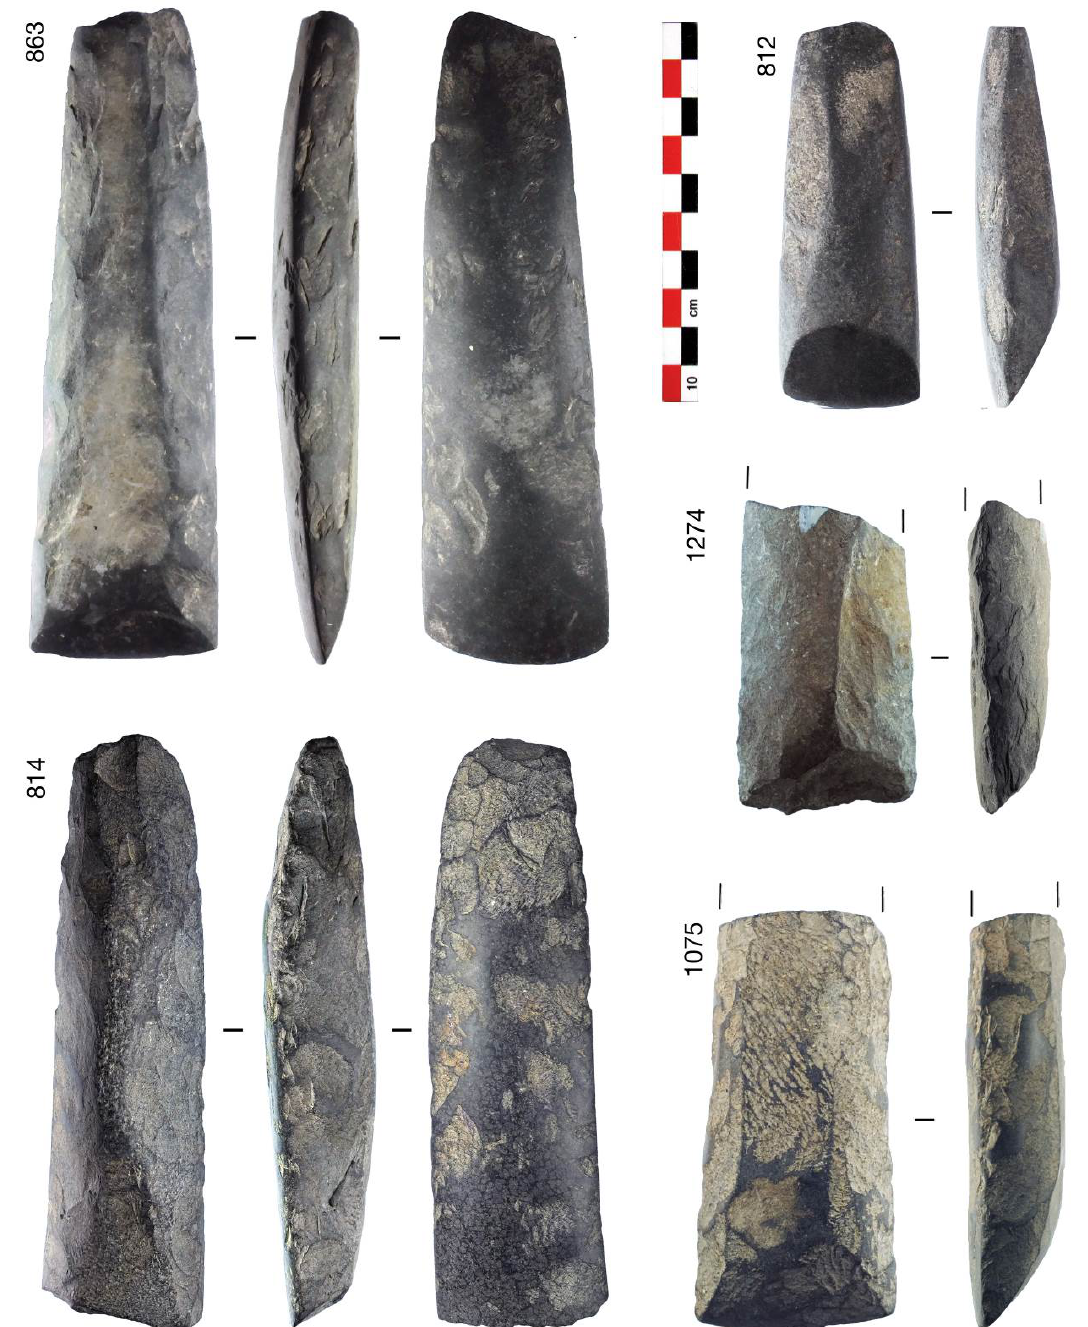
Figure 8. Lames polies d'Atiahara: type 2A de Duff. Echelle de 10 cm (segments de 1cm) Figure 8. Atiahara adze blades: Duff type 2A. The scale bar in the image is 10 cm wide (separated into 1 cm